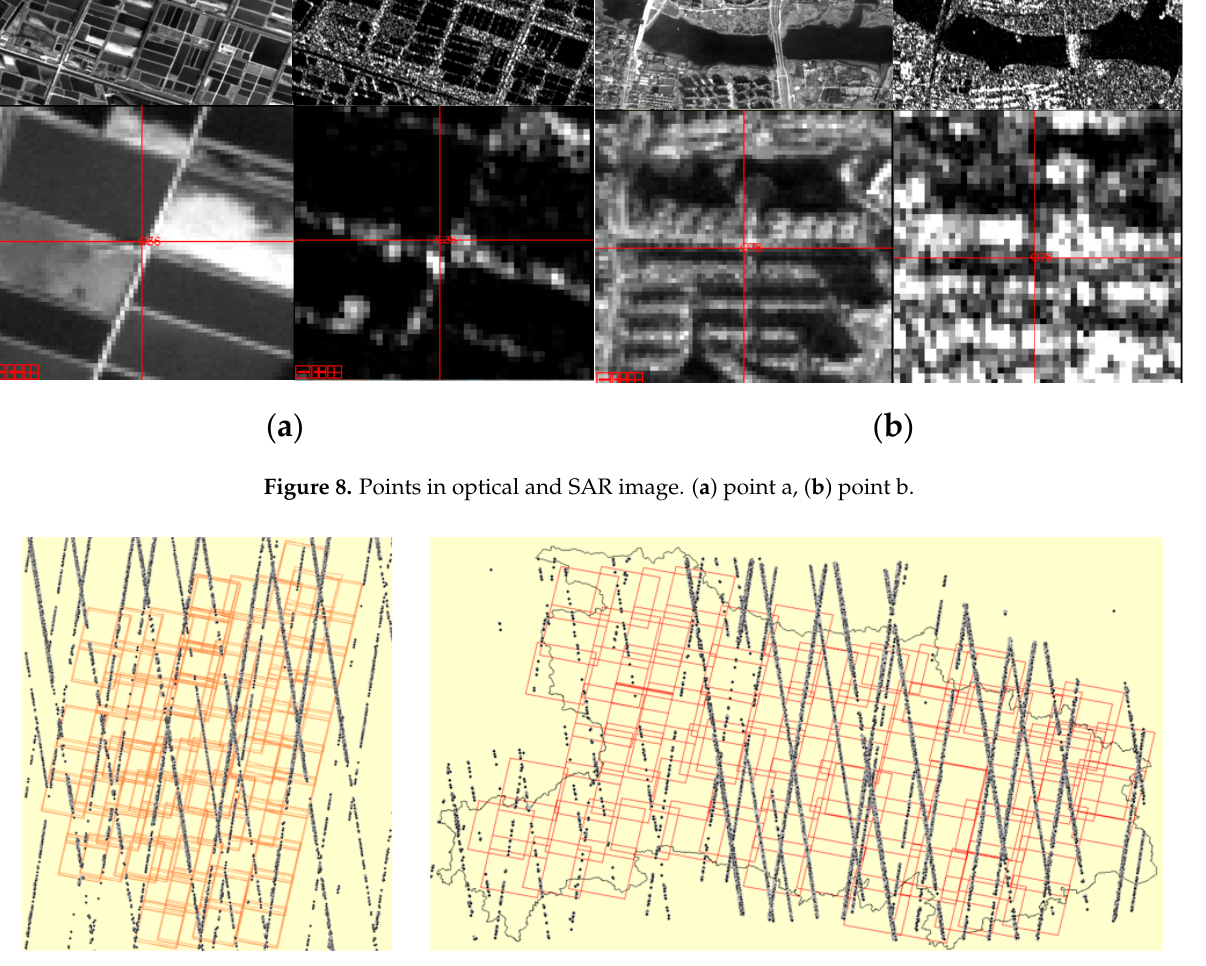
Figure 9. Distribution of LAPs. ( a ) ZY-3 in Jiangxi Area, ( b ) Mapping Satellite-1 in Hubei Area. After obtaining PCPs and LAPs as control points, in order to verify the effectiveness of adding LAPs and PCPs as control conditions to the adjustment and analyze the influence of the inconsistency of the object-image coordinates on the adjustment results, tests were conducted according to the following scheme. In addition, to study the influence of the plane position accuracy on the effect of the extracted LAPs, there are two options for acquiring the plane coordinate of the LAPs, namely, conducting adjustment with PCPs to enhance the plane positioning accuracy of the image before acquiring the LAPs and not using the PCPs before acquiring the LAPs. Plan A: free network adjustment without PCPs or